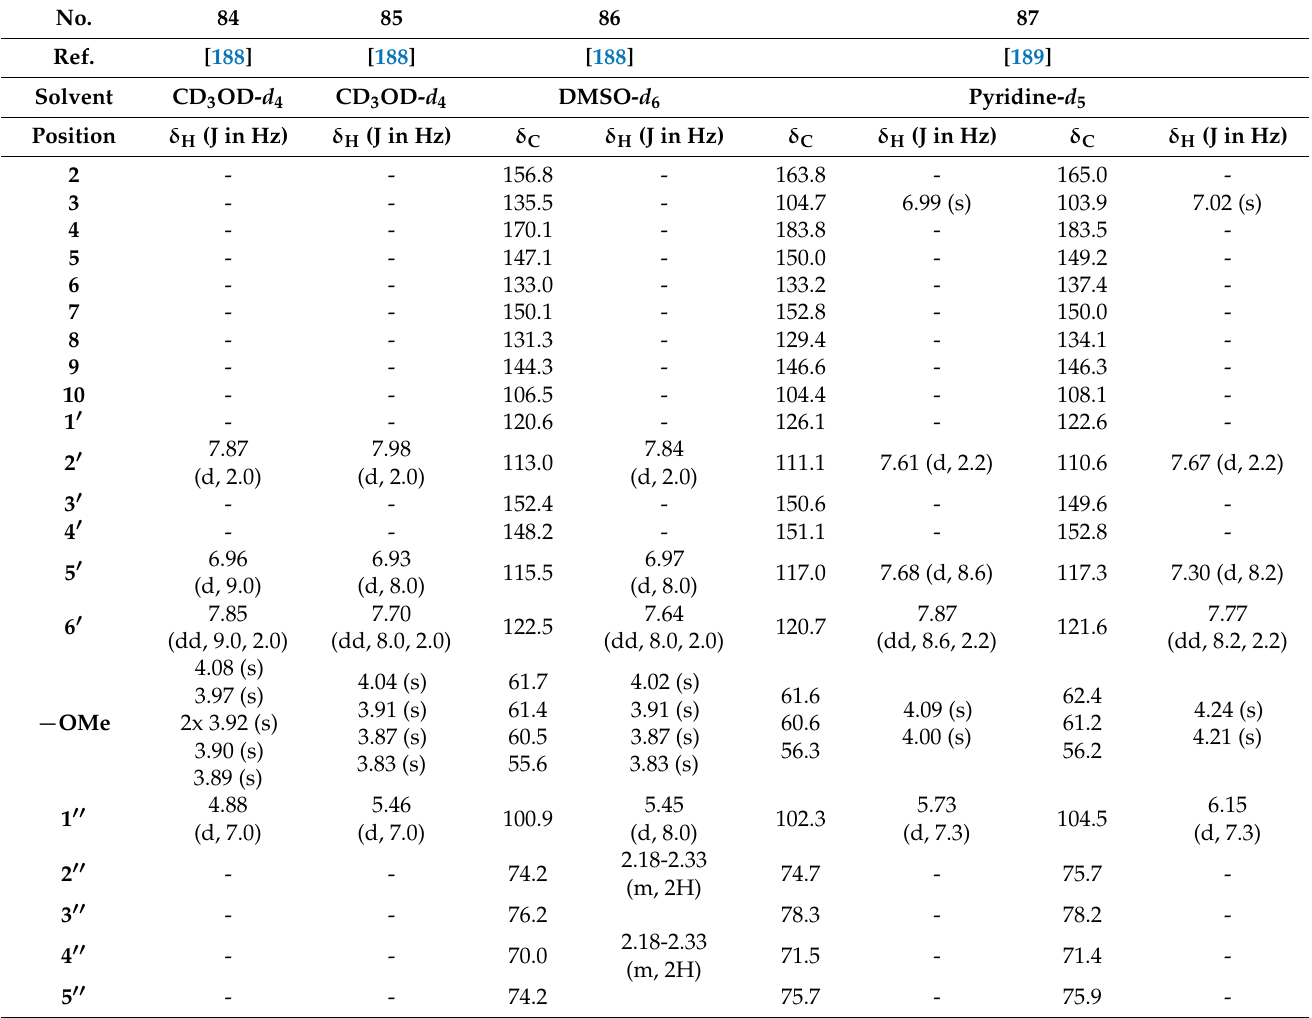
Table 17. Glycosylated flavones ( 84 – 87 ) extracted from Citrus